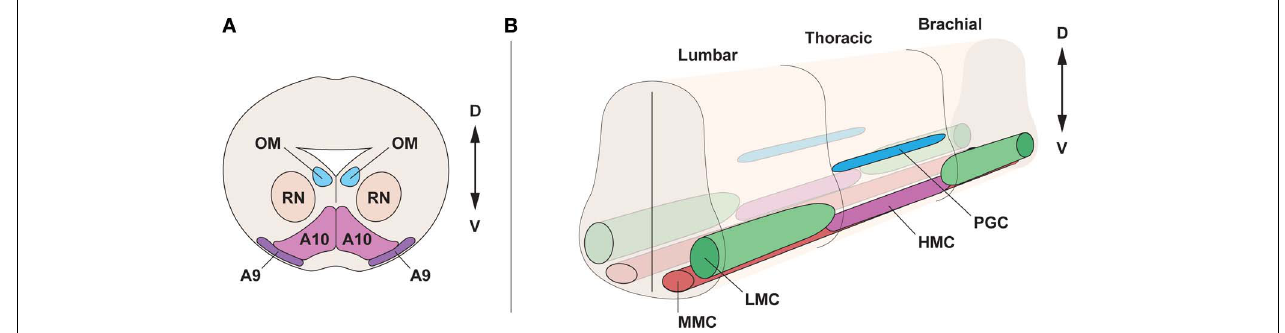
FIGURE 1 | Topographical organization of the midbrain and spinal cord in the embryo. (A) Cross section of the midbrain, at E15.5, displaying oculomotor motor neurons (OM), innervating the ocular muscles, neurons of the red nucleus (RN) and dopamine neurons, subdivided into substantia nigra (A9) and ventral tegmental area (A10). (B) Motor neuron division in motor columns along the spinal cord at E13.5. Lateral motor column (LMC) motor